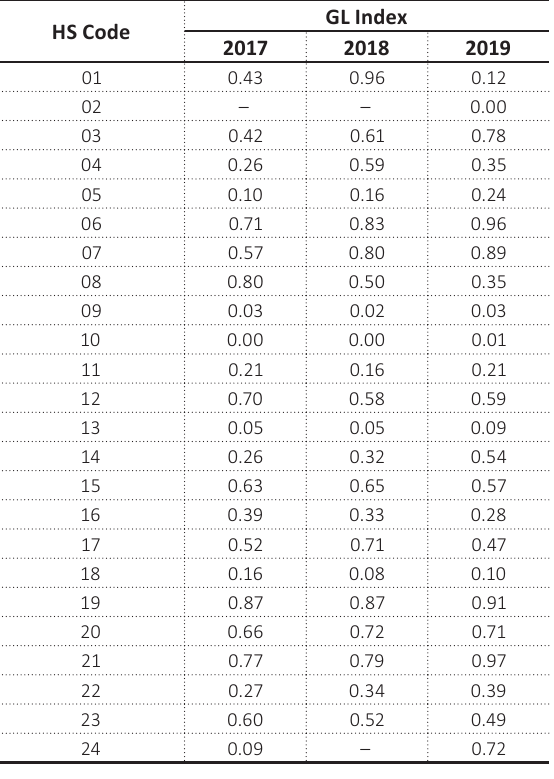
Table 5. GL index based on HS01-HS24